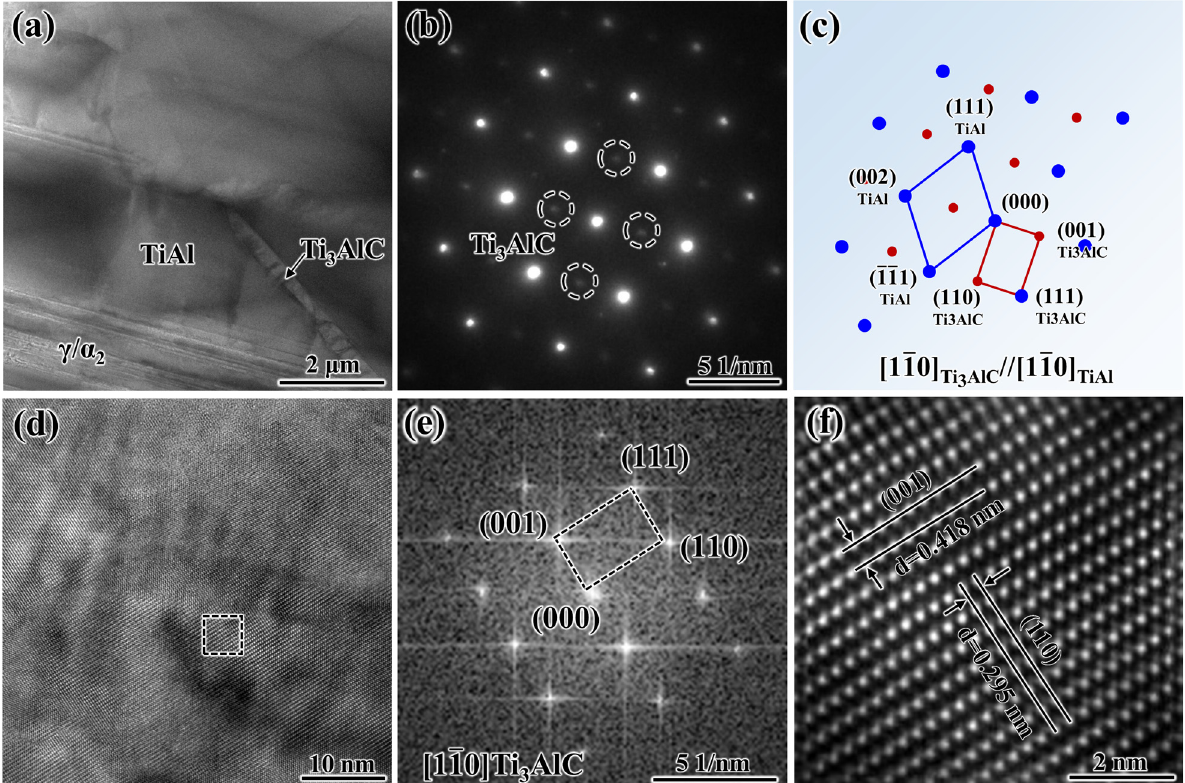
Figure 7: The TEM analysis of rod - like Ti 3 AlC precipitate after growth in TiAl alloys: ( a ) TEM image of Ti 3 AlC and TiAl; ( b ) SAED pattern of Ti 3 AlC and TiAl; ( c ) indexing of the FFT pattern in ( b ) ; ( d ) TEM image of rod - like Ti 3 AlC; ( e ) FFT pattern of Ti 3 AlC; and ( f ) IFFT image of Ti 3